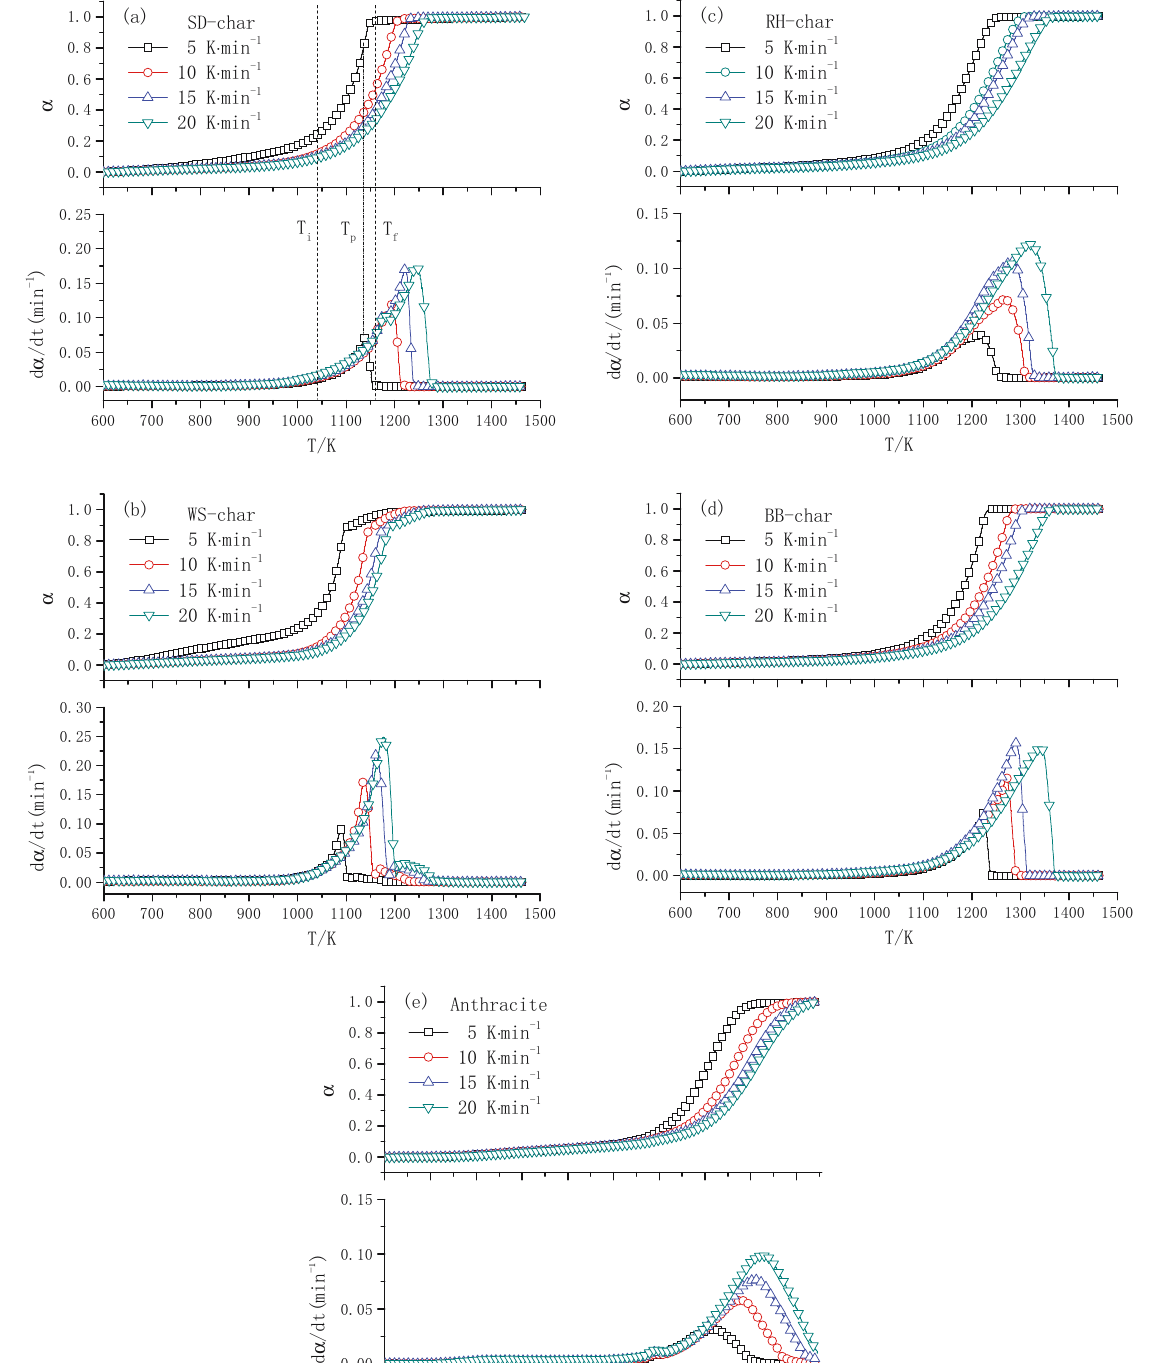
Figure 3: Gasi fi cation curves of di ff erent carbonaceous materials with CO 2 : ( a ) SD - char; ( b ) WS - char; ( c ) RH - char; ( d ) BB - char and ( e )